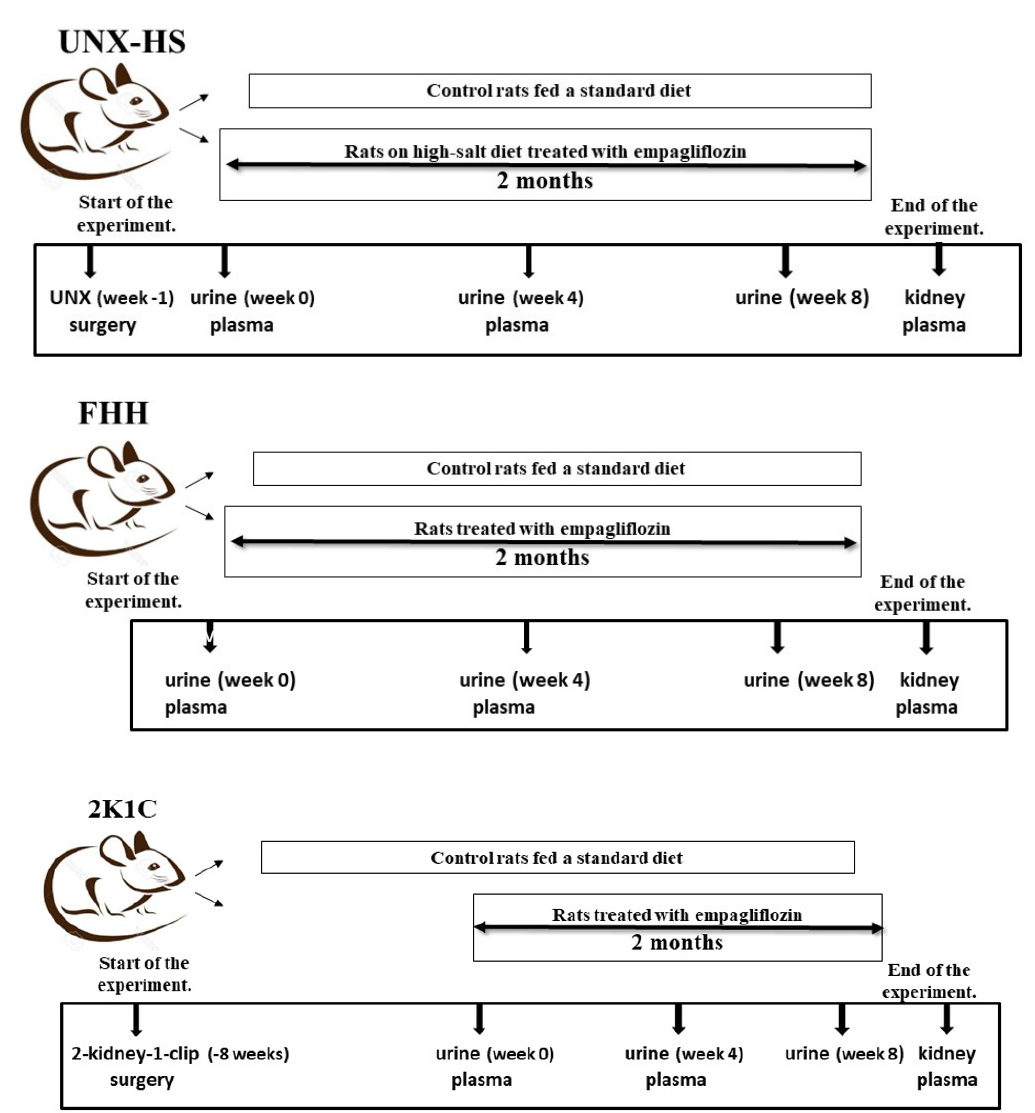
Figure 1. Scheme of the experiment in Fawn-hooded hypertensive rats (FHH), 2-kidney-one-clip (2K1C), and uninephrectomized high salt-fed (UNX-HS) rats. Body weight was monitored throughout the whole experiment and measured once a week. Systolic blood pressure was measured weekly during the experiment using tail plethysmography (HatterasInstruments, Cary, NC, USA). Food consumption was monitored throughout the